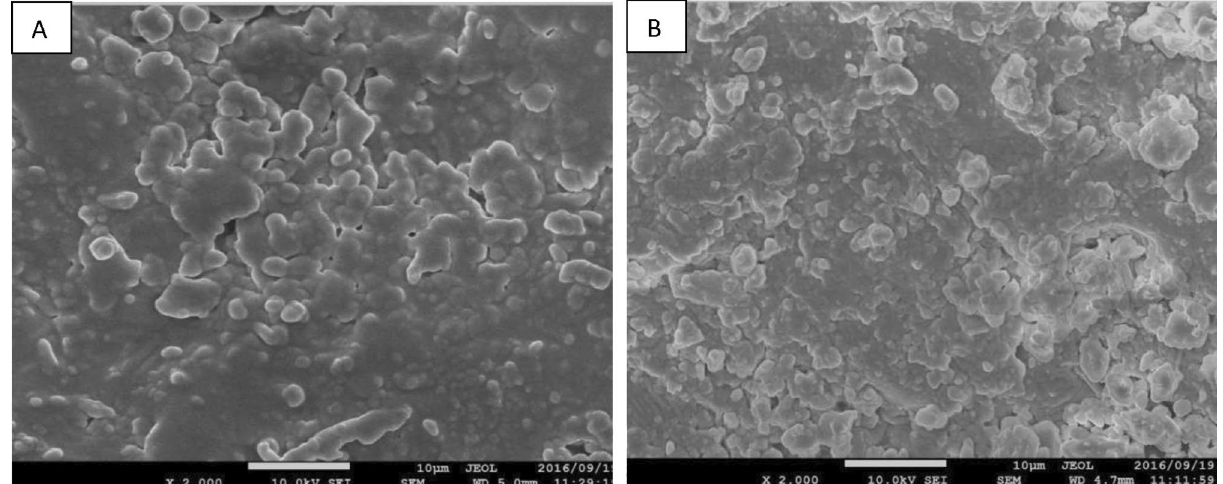
Figure 4. Scanning electron microscope (SEM) images of seed surface at 10 µm. ( A ) control (without plasma treatment). ( B ) seed surface after receiving 180 s, 50 W plasma treatment. The images were taken from identical locations on the dorsal side of the wheat kernels.